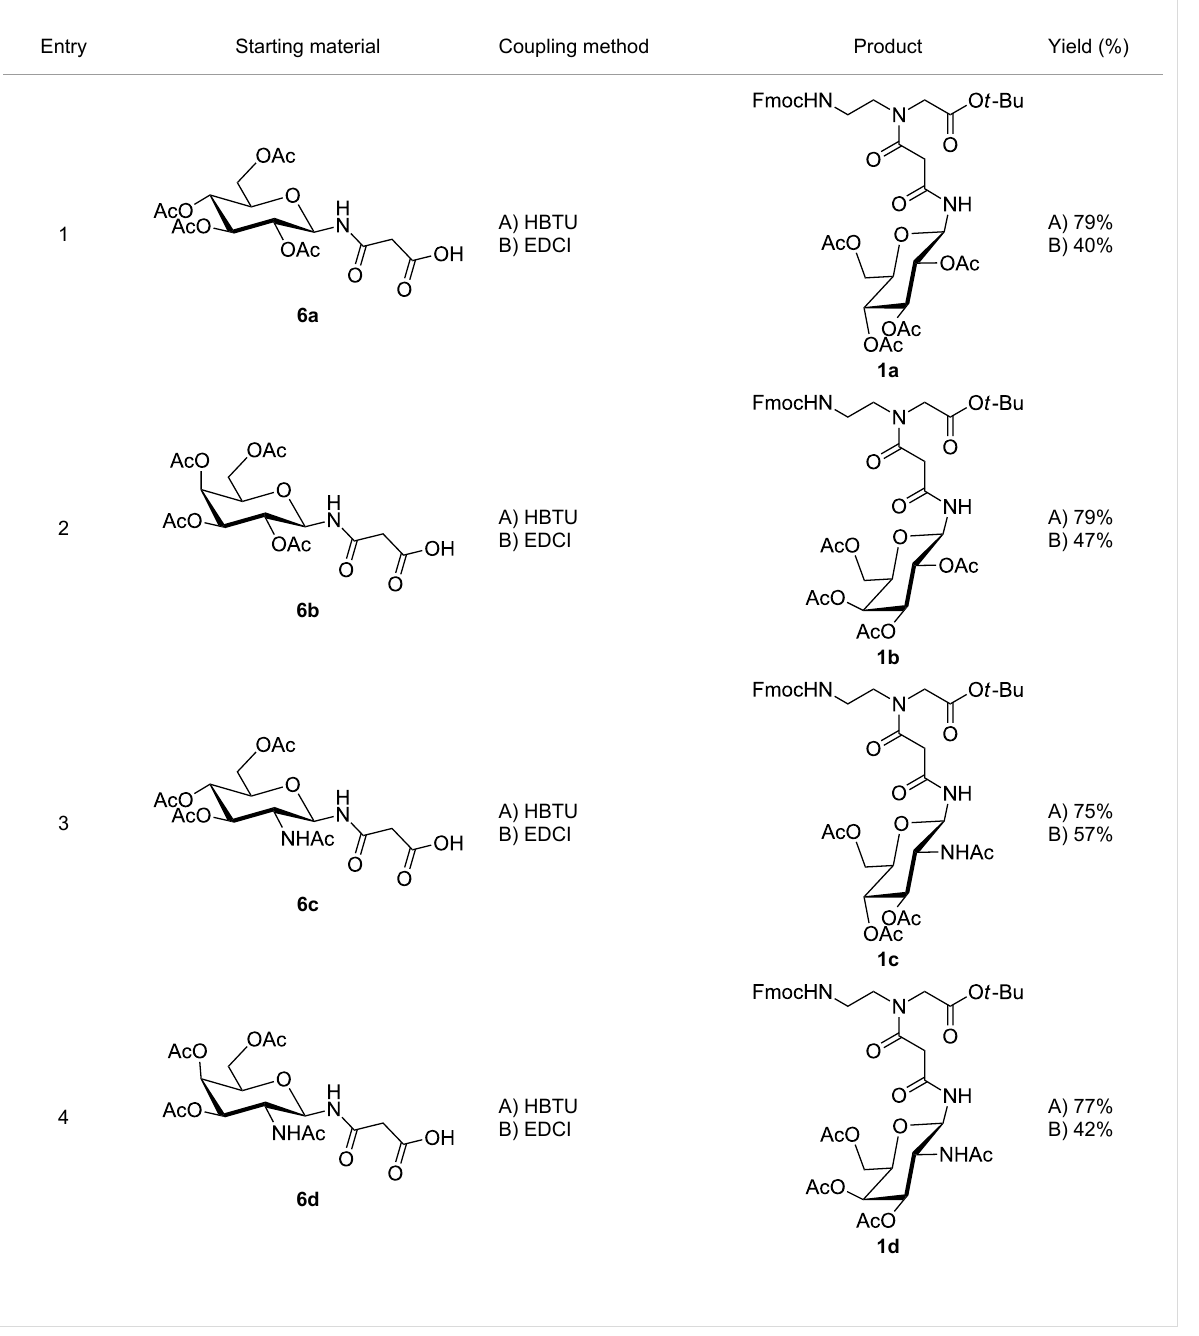
Table 1: Synthesis of building blocks 1a–d